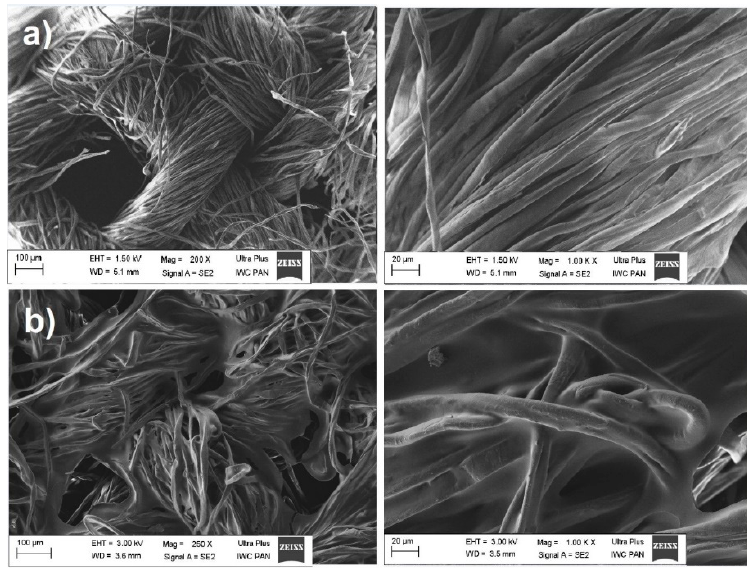
Figure 11. Pictures of SEM agro-fabrics uncoated ( a ) and coated with starch film ( b ), magnification 250× and 1000×.